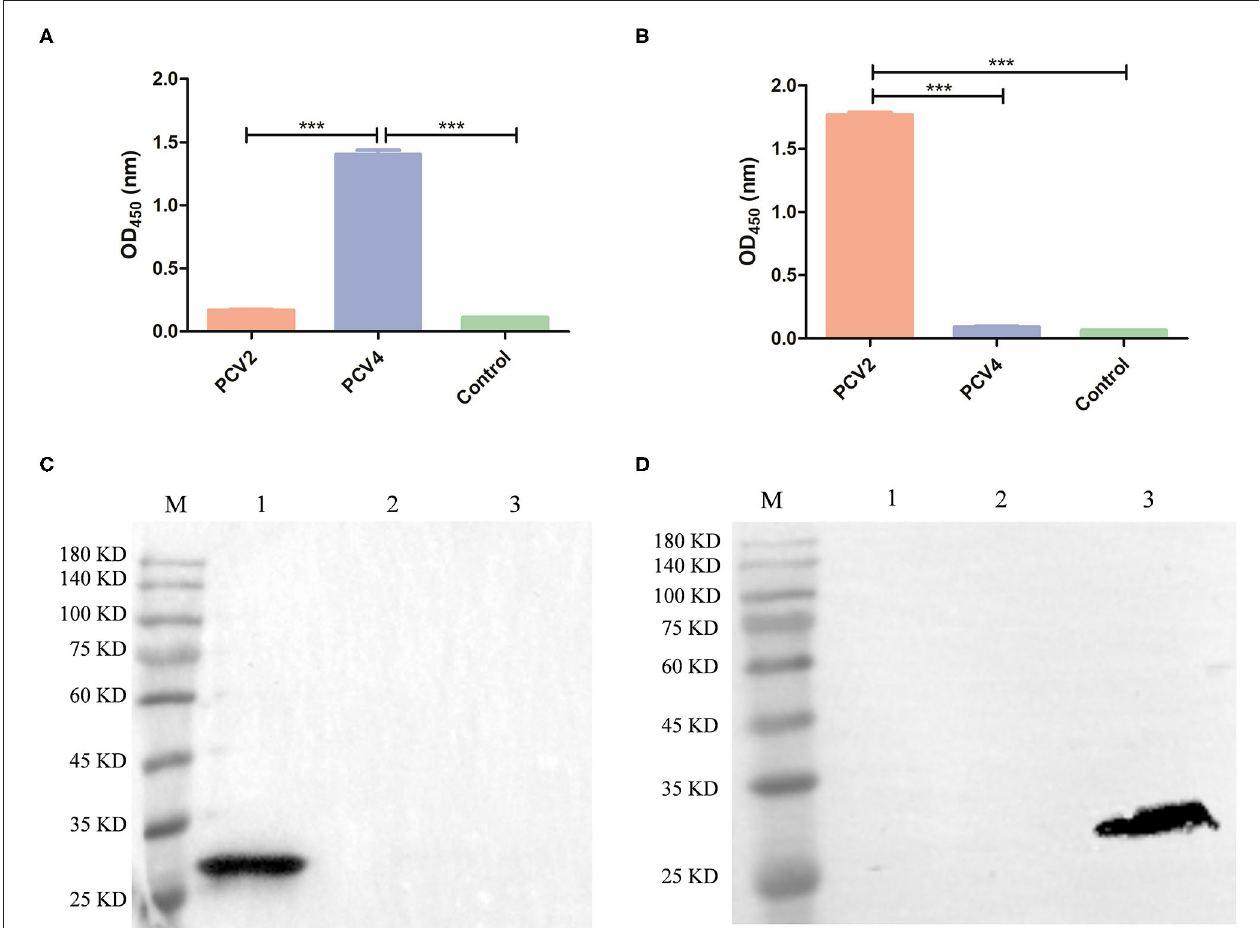
FIGURE 4 | Cross-reaction between PCV4 and PCV2 by ELISA and Western blots. The reactivity of PCV4 VLP-immunized (A) or PCV2 VLP-immunized (B) mouse serum ( n = 4) with PCV4 or PCV2 by ELISA. Reactivity of sera from PCV4 or PCV2 VLP-immunized mice, collected 6 weeks after initial immunization. Immunized mice ( n = 2) received PBS as a control. Optical densities were read at 450nm. *** p < 0.001. (C,D) Western blots of PCV Cap proteins using anti-PCV4 Cap serum or anti-PCV2 Cap serum, respectively (lane M: protein marker; lane 1: PCV4 Cap; lane 2: PCV3 Cap; and lane 3: PCV2